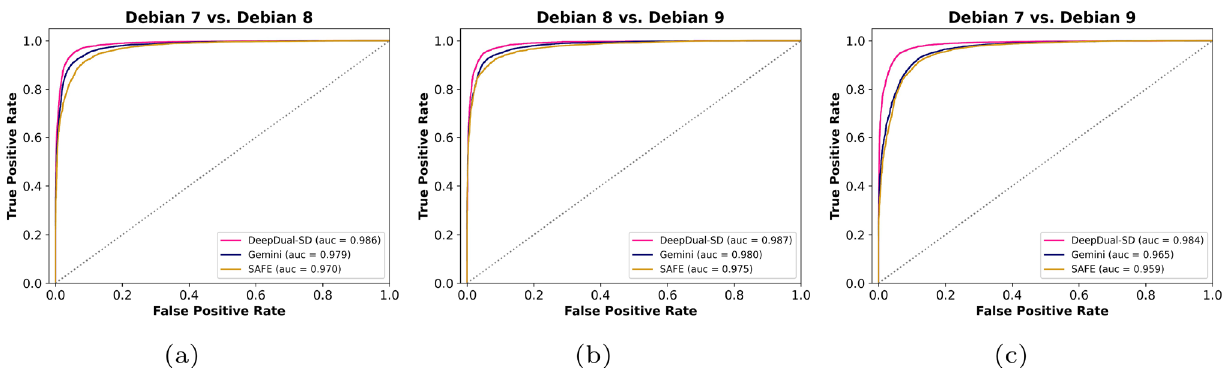
Fig. 6 ROC curves for different approaches comparison on binaries from Debian7.11, Debian8.11 and